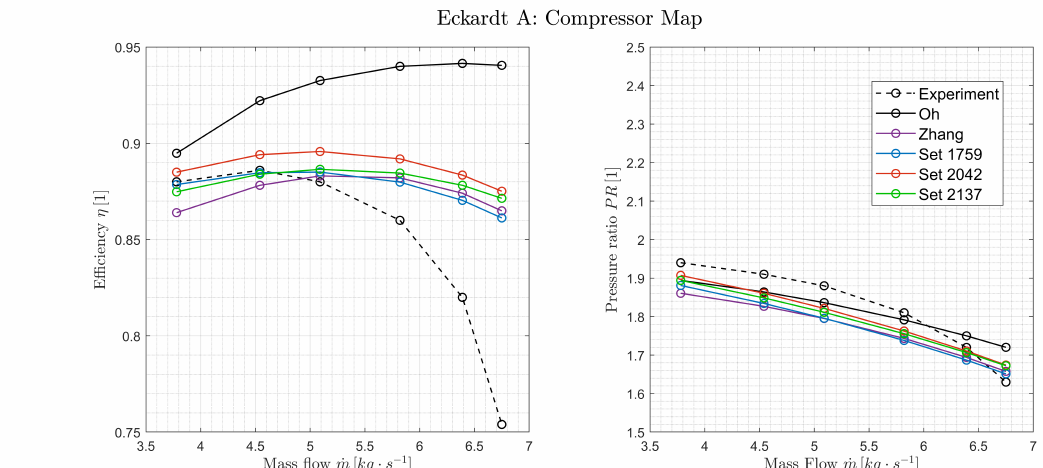
Figure 10. Eckardt A compressor map ( RPM = 14,000 min − 1 ) for chosen loss model sets in comparison to experimental data: ( left ) Efficiency; ( right ) pressure